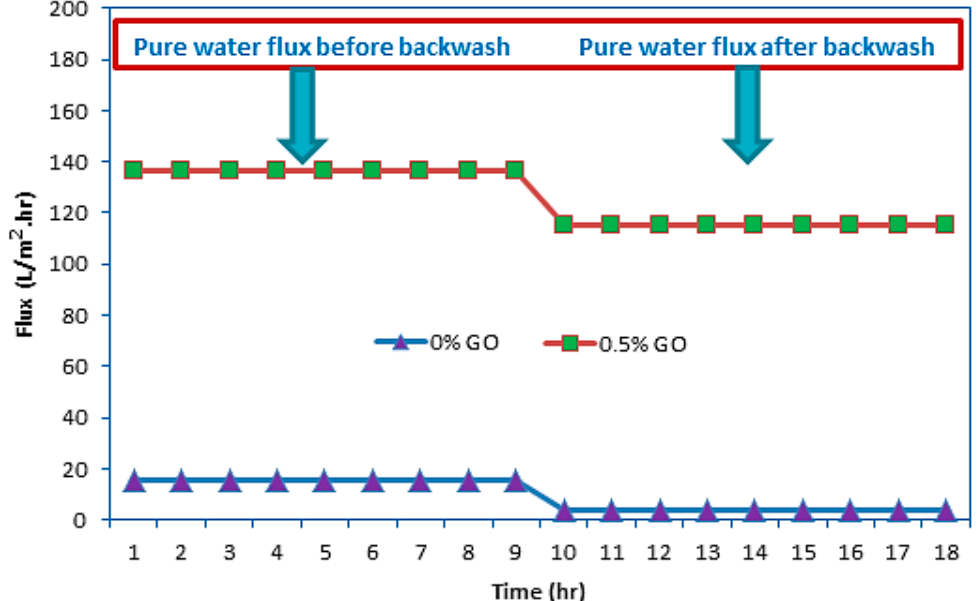
Figure 11. Pure water flux before and after backwashing for 18 h at pressure of 3 bar.